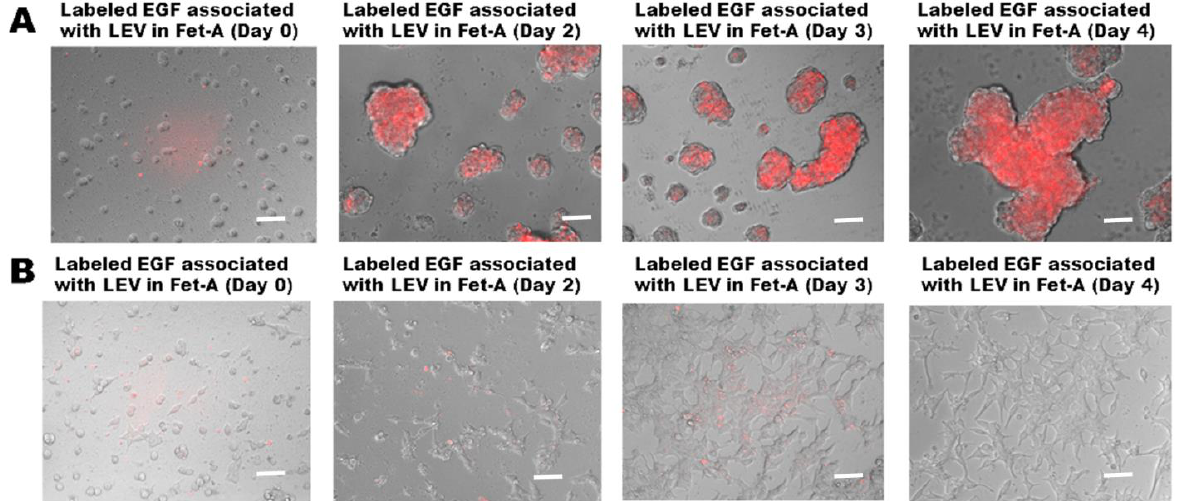
Figure 4. Large extracellular vesicles (LEV) associated with EGF remain sequestered on the cell surface to promote 3-D growth. LEVs were loaded with rhodamine isothiocyanate labeled EGF and then added (15 µ g/well) to LNCaP cells (5000 cells/well) plated on either a low attachment plate (Panel ( A )) or a cell culture-treated high attachment plate (Panel ( B )) and then allowed to grow for four days. On days 2, 3, and 4, after plating the cells, the images of the spheroids or attached spread cells associated with labeled EGF were acquired by a Keyence epifluorescence microscope. Scale bar = 50 µ m. The experiment was repeated 3 times.